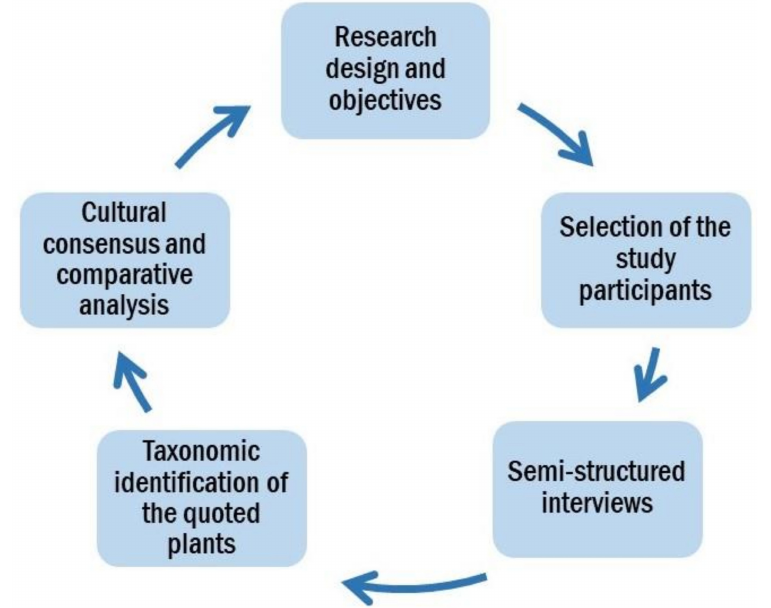
Figure 3. Overall methodological scheme.